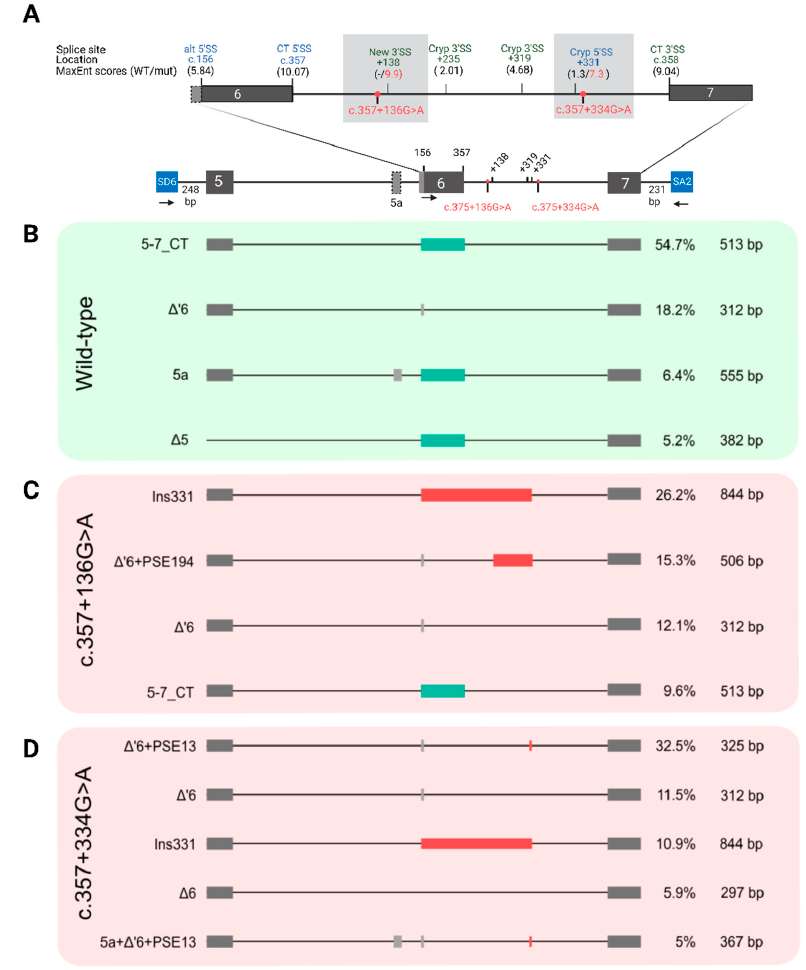
Figure 1. Splicing outcomes for two spliceogenic deep-intronic variants located in intron 6 of PAX6 using in vitro minigene assays. ( A ) Schematic representation of the multi-exonic minigene construction generated from an exon trapping pSLP3 vector (blue boxes) containing exons 5 to 7 of PAX6 . The alternative 5 exon (5a) and the partially skipped exon 6 ( ∆ ’6) are shown with dashed lines. Localization of the deep-intronic variants c.357+136G>A and c.357+334G>A (red dot) on intron 6 and the primers (arrowheads) used for RT-PCR amplification for long-read sequencing (SD6-F and SA2-R) and semi-quantitative PCR (PAX6-F and SA2-R) are shown. The natural donor (5 ′ SS, blue) and acceptor (3 ′ SS, green) splicing sites of exons 6 and 7 are represented as well as different alternative (alt) and predicted cryptic (cryp) splicing sites, indicating their splice prediction scores from the MaxEnt tool (WT and mutant scores are colored in black and red, respectively). ( B – D ) Isoform patterns, their relative abundances (in percentages), and isoform sizes (in base pairs) for the wild-type and the two mutated constructions obtained by long-read sequencing of RT-PCR fragments. Only isoforms with values above a threshold of 5% are shown. ( B ) Wild-type construction yielded three predominant isoforms corresponding to the canonical transcript (5–7_CT), including exons 5, 6, and 7, and two alternative isoforms, a partially skipped exon 6 ( ∆ ’6) and the alternative 5 exon (5a). ( C , D ) For the mutant minigenes, a mixture of aberrant splice amplicons (in red) was obtained, including a shared intronic retention of 331-nt (Ins331) and the inclusion of pseudoexons (PSEs) of 194-nt (PSE194) and 13-nt (PSE13) (not shown) for c.357+136G>A and 13-nt (PSE13) and 97-nt (PSE97) (not shown) for c.357+334G>A. SS: splicing site. Cryp: cryptic. CT: canonical transcript. PSE: pseudoexon insertion. Ins: insertion.